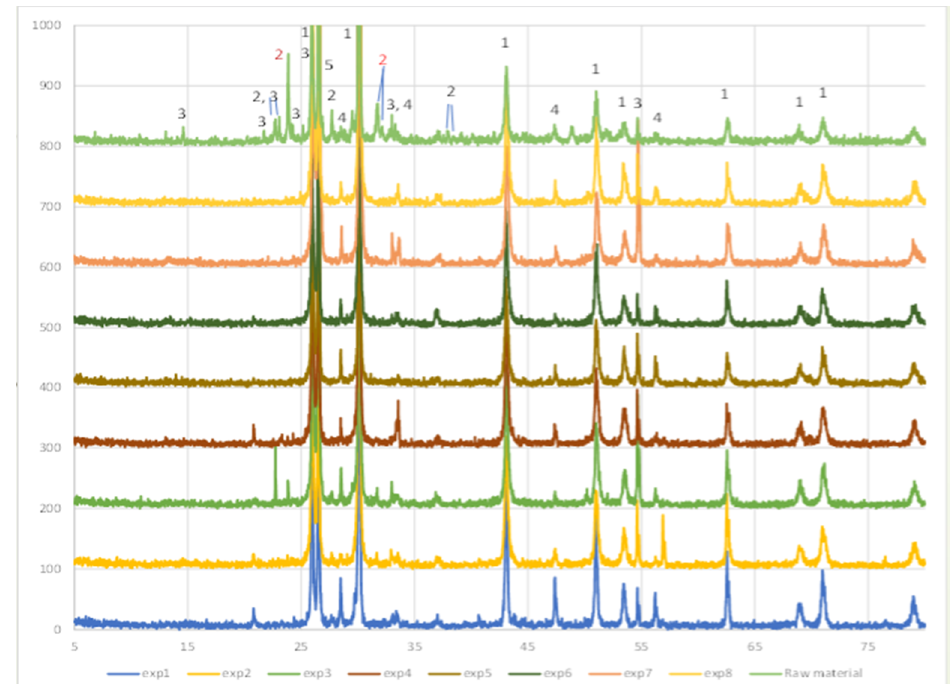
Figure 4. XRD patterns of solid residues compared to the initial galena concentrate (1 galena, 2 bulangerite, 3 jamesonite, 4 sphalerite, 5 quartz).